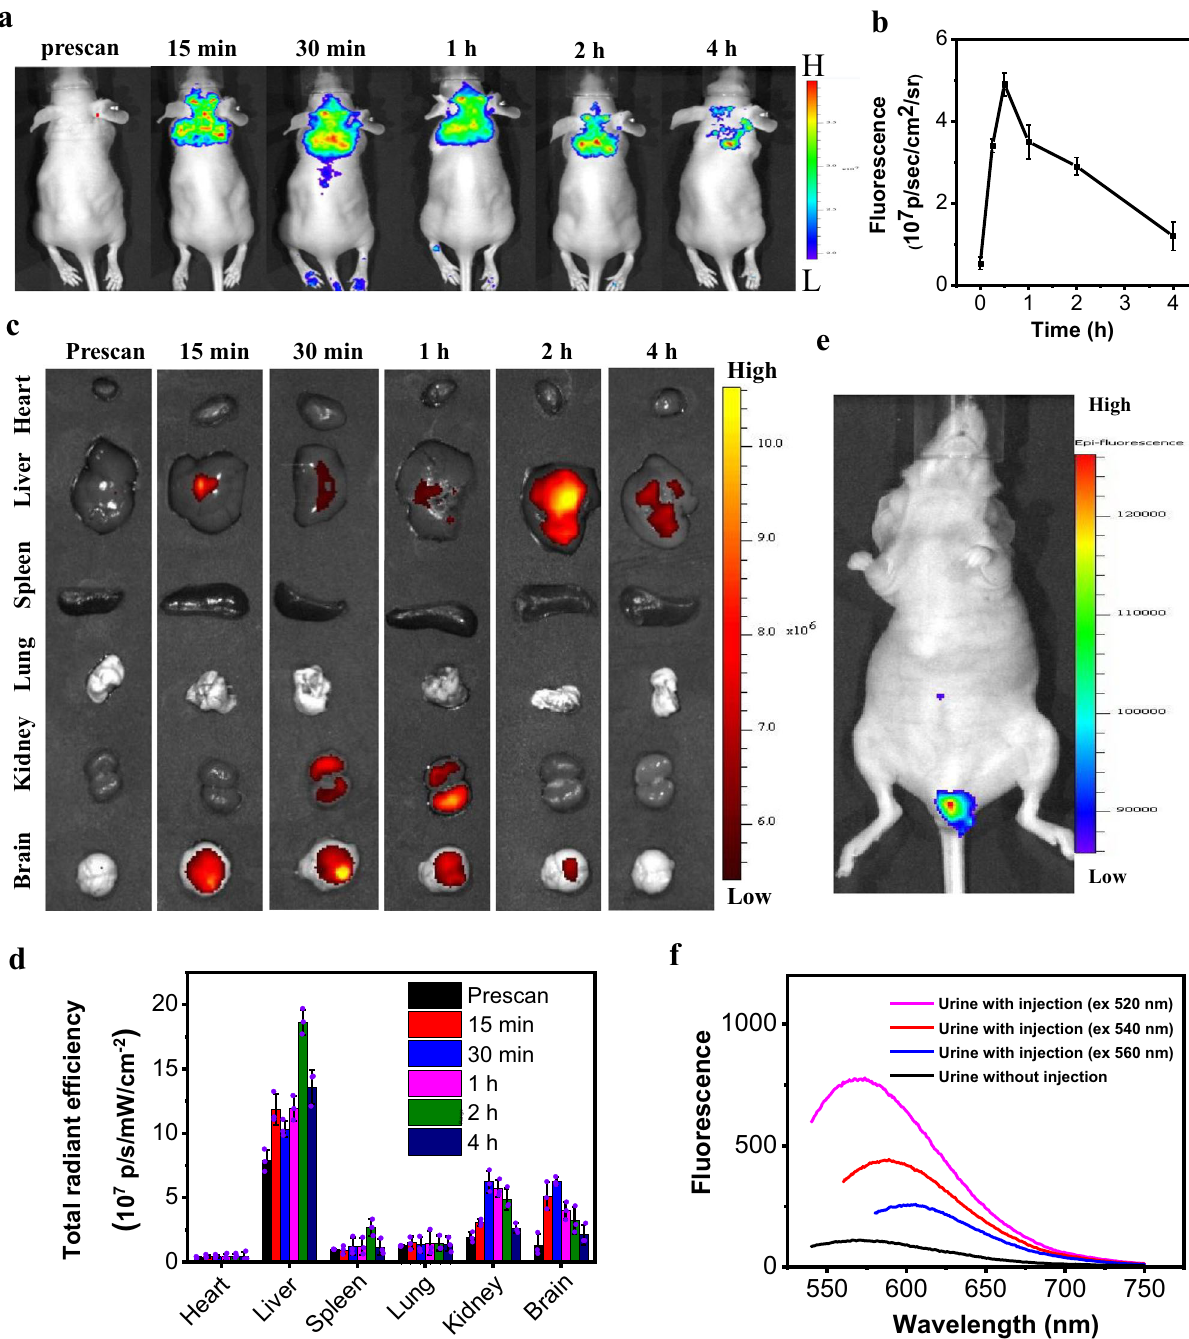
Fig. 5 Evaluation of Mn@CCs preferentially target the microscopic gliomas in an intracranial mouse model by fl uorescent imaging. a The in vivo fl uorescence images of U87MG glioma-bearing mice at different timepoints after intravenous administration of Mn@CCs (ex: 500 nm; em: fi lter dsRED). b The changes of the mean fl uorescence intensity over time of Mn@CCs in brain parenchyma ( n = 3 biologically independent animals). All the statistical data are expressed as mean values ± SD. The mean fl uorescence intensity was calculated by ImageJ. c Ex vivo fl uorescence images of organs excised at different timepoints post-i.v. injection of Mn@CCs. d Quanti fi cation of fl uorescence signals of heart, liver, spleen, lung, kidney, and brain obtained from the ex vivo imaging data (ex: 500 nm; em: DsRed) ( n = 3 biologically independent animals). All the statistical data are expressed as mean values ± SD. e Representative in vivo fl uorescence image of the bladder area after i.v. injection of Mn@CCs at 1 h (ex: 500 nm; em: fi lter dsRED) ( n = 3 biologically independent animals). f Fluorescent analysis of the urine samples obtained from the mice with and without